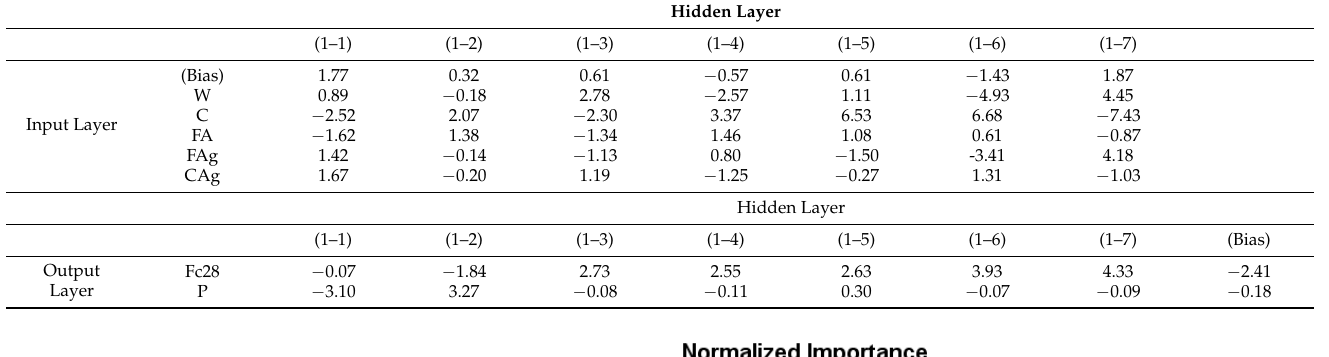
Figure 3. Architecture layout for the developed ANN models.